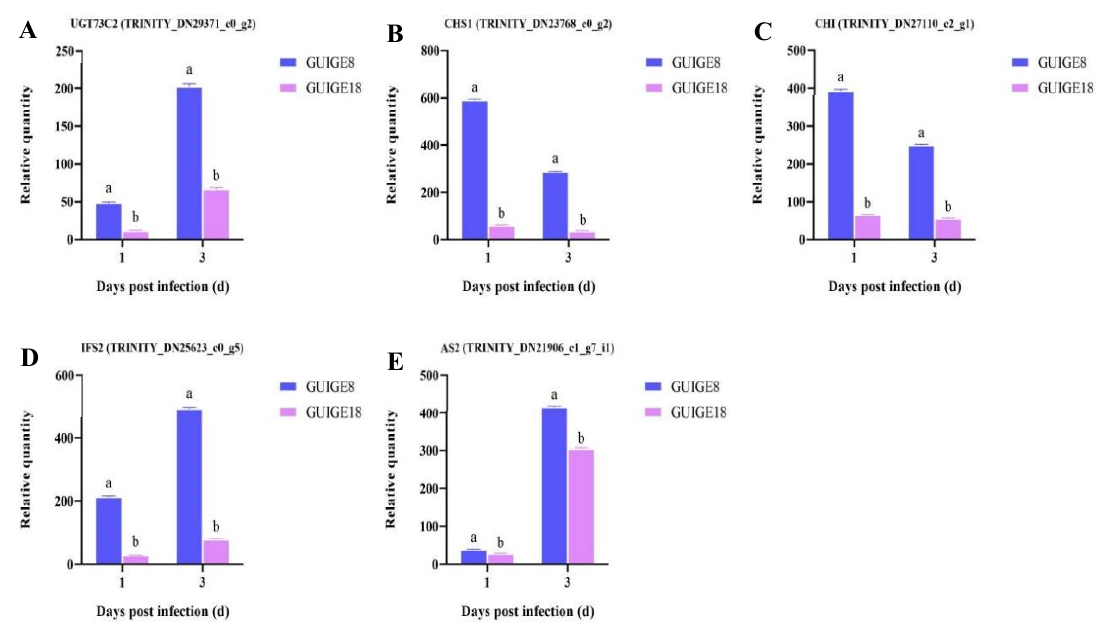
Figure 11. The expression of DEGs related to flavonoid biosynthetic process. ( A ) UGT73C2; ( B ) CHS1; ( C ) CHI; ( D ) IFS2; and ( E ) AS2. The Y axis shows the relative quantity means of three independent replicates, calculated using the 2 − △△ Ct method. Letters ‘a/b’ indicate differences change between the two cultivars on the same day ( p < 0.05), according to Duncan’s multiple range test using SPSS software.